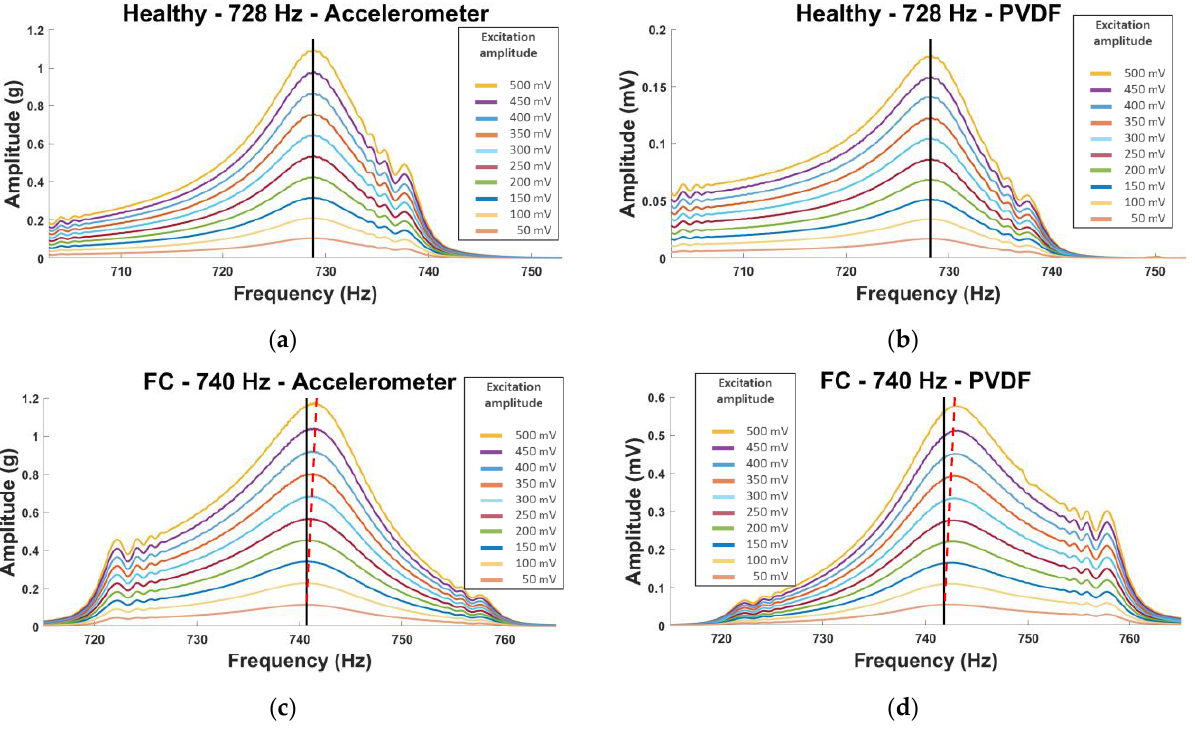
Figure 9. Amplitude vs. frequency curves for ( a , b ) healthy and ( c , d ) FC plates using the NLR method. ( a , c ) Accelerometer and ( b , d ) PVDF